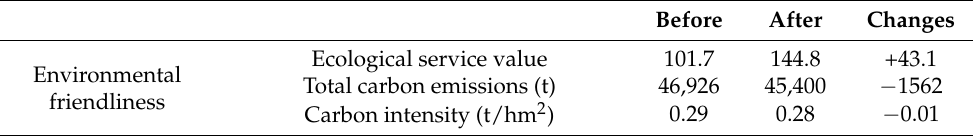
Table 5. Comparison of environmental friendliness indicators before and after the farmland rights system reform. Before After Changes Ecological service value Environmental friendliness